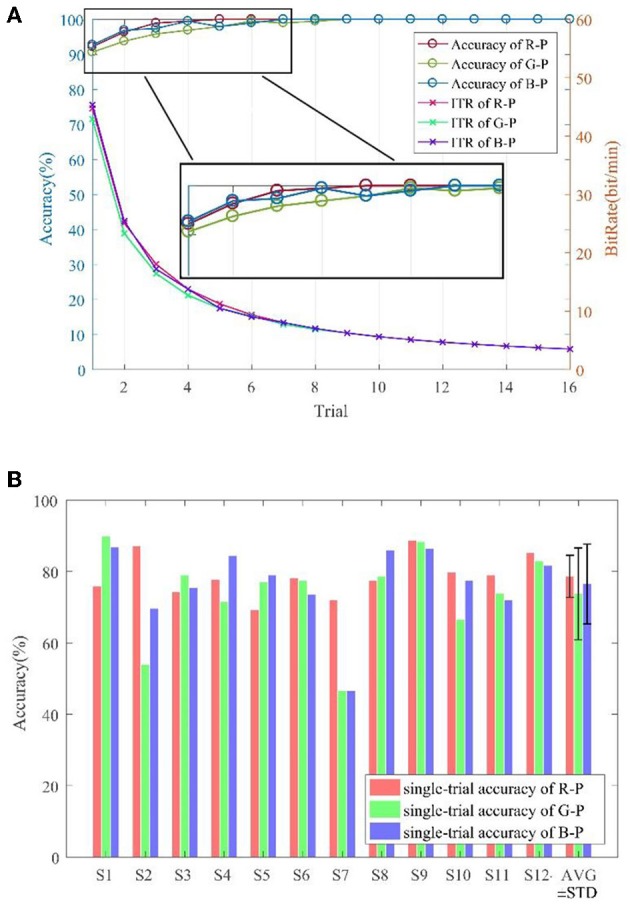
Offline accuracy and bit rate analysis. (A) Overlapping average per trial. (B) Single-trial per subject.